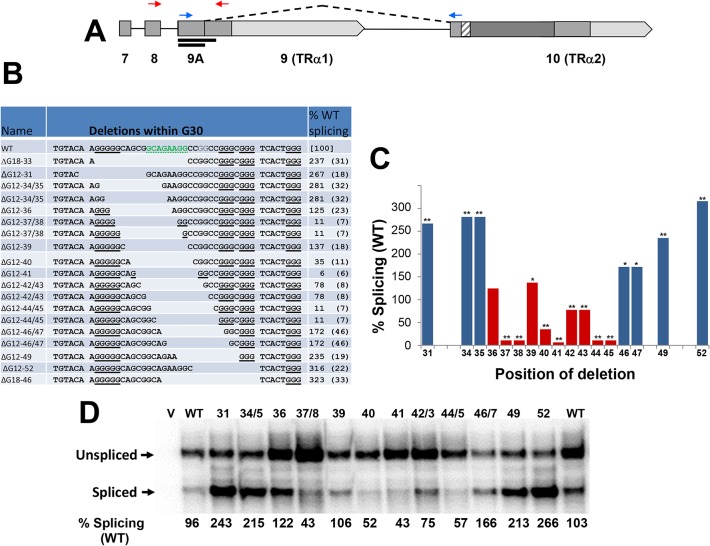
Role of G-clusters in G30 probed by deletion scanning mutations.
(A) Diagram of the structure of the ErbAm minigene as in Fig 4A. The longer line under exon 9 represents the riboprobe used for RNase protection assays in panel D, the shorter line RNase protected probe annealed to spliced TRα2 mRNA. (B) Sequences of closely spaced 12 and 18 nucleotide deletions (ΔG12, ΔG18) are indicated within the G30 region. Deletions are named according to the position of their 5’ ends in exon 10. Clusters of three or more G residues are underlined. The possible 8-nt splicing enhancer sequence is highlighted in the wildtype sequence. The positions of some deletions are ambiguous, and these are shown twice to emphasize stepwise positioning of the deletions. TRα2 splicing determined by real-time RT-PCR is shown at right as % of wildtype splicing with standard deviation given in parentheses (N = 3–6); WT = 25% TRα2 splicing (SD 6.2%). (C) Bar graph summarizing results from ΔG12 deletions in panel A. Ambiguous positions are indicated with two identical bars; blue bars indicate deletions which disrupt at least one G3 cluster. One or two asterisks indicate the significance of the change in expression of TRα2 in mutant compared to WT (p < 0.05 or p <0.01, respectively). (D) Autoradiogram showing results from RNase protection assays carried out in parallel using a probe complementary to the TRα2 5’ss in exon 9. Minigene deletions are labeled similarly to panel B with ambiguous positions indicated with forward slash.